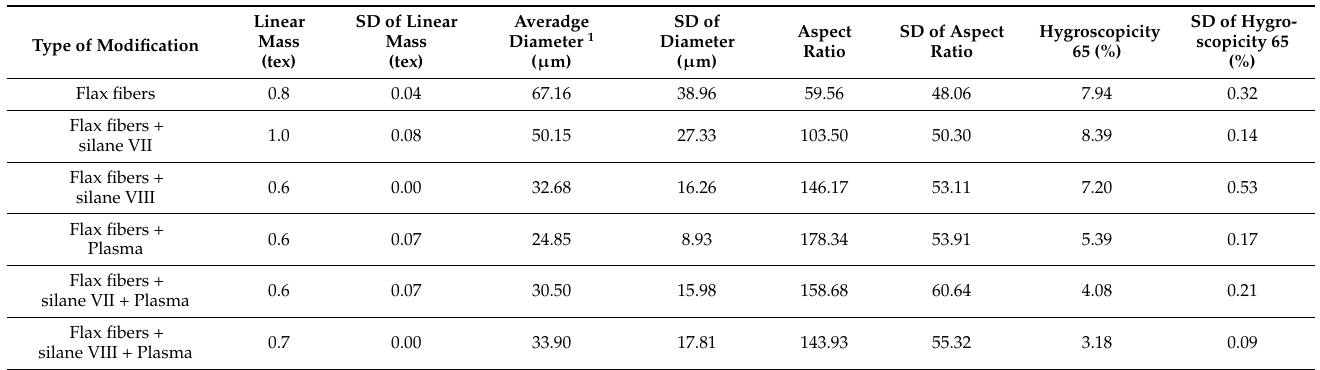
Table 3. Evaluation of flax fibers, before and after chemical/physical